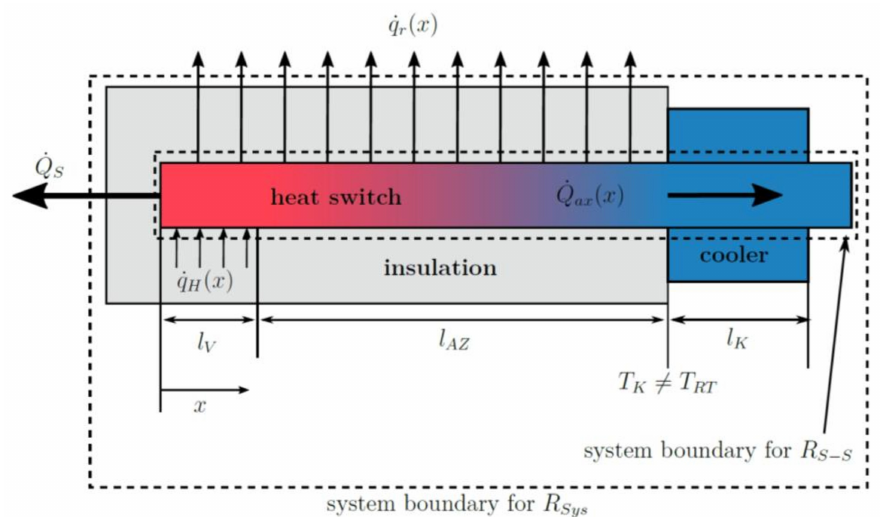
Figure 3. Illustration of heat fluxes and other relevant parameters in the heat switch used for modeling the ideal thermal resistance R S − S (i.e., without parasitic thermal losses). The respective system boundaries for R S − S and R Sys are also